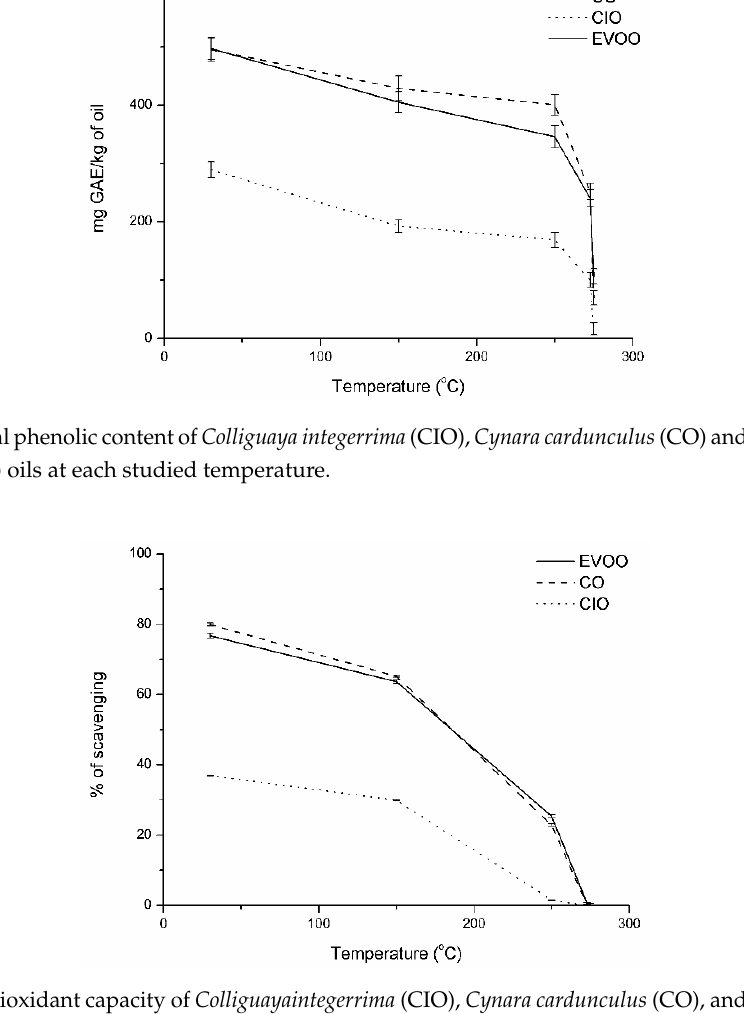
Figure 5. Antioxidant capacity of Colliguayaintegerrima (CIO), Cynara cardunculus (CO), and extra-virgin olive (EVOO) oils at each studied temperature.